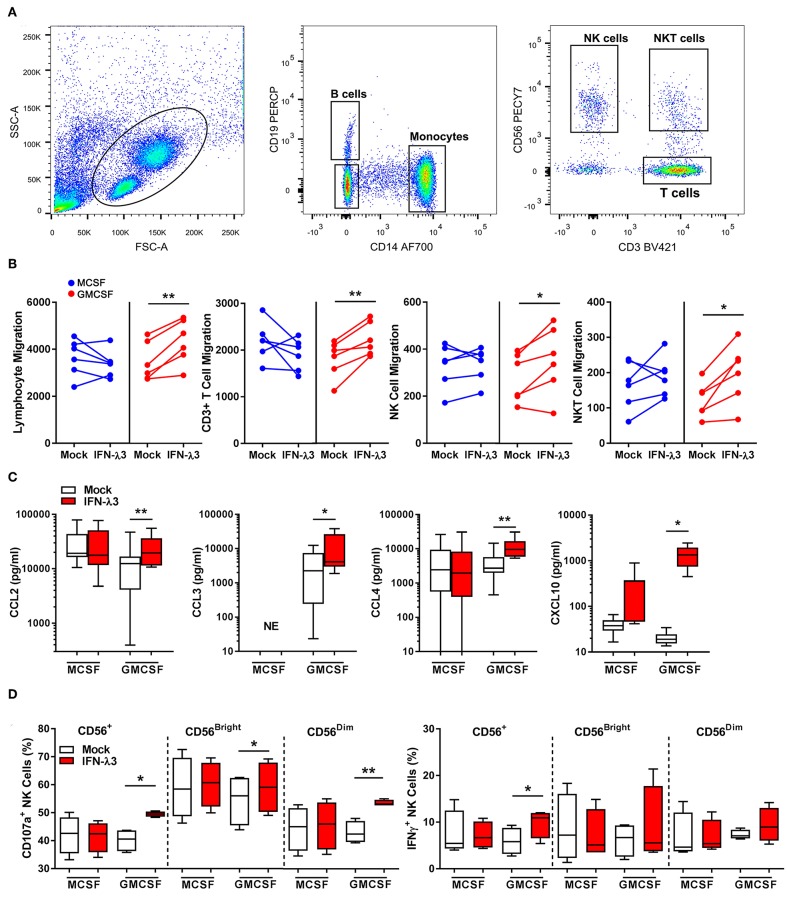
Macrophages differentiated with IFN-λ3 induce lymphocyte chemotaxis and NK cell activation. Transwell inserts containing autologous PBMCs were placed into wells containing 6-day differentiated Mϕs ± IFN-λ3 to examine immune cell chemotaxis (n = 6). Migrated cells were analyzed by flow cytometry using CD14, CD19, CD3, and CD56 antibodies to identify the number of migrated monocytes, B, NK, and T cells (A). The addition of IFN-λ3 to GM-CSF Mϕs alone, stimulated lymphocyte migration, with significant increases in NK, NKT, and T cell migration (B). Consistent with migration data, GM-Mϕ CCL2, CCL3,CCL4, and CXCL10 secretion were significantly increased by IFN-λ3, with no significant effect on M-Mϕs (C) (n = 7). To assess the role of IFN-λ3 on Mϕ activation of NK cells, autologous NK cells were incubated with Mϕs for 16 h a ratio of 1:1, removed and incubated with K562 target cells for a further 6 h to measure cytotoxicity by degranulation and IFN-γ expression (n = 4). GM-Mϕs differentiated with IFN-λ3 significantly increased NK cell cytotoxicity as measured by CD107a expression, as well as IFN-γ production (D). Data are representative of two (B,D) and three (C) independent experiments. Paired t-test *p < 0.05, **p < 0.01 (mean ± SE). NE, No expression.